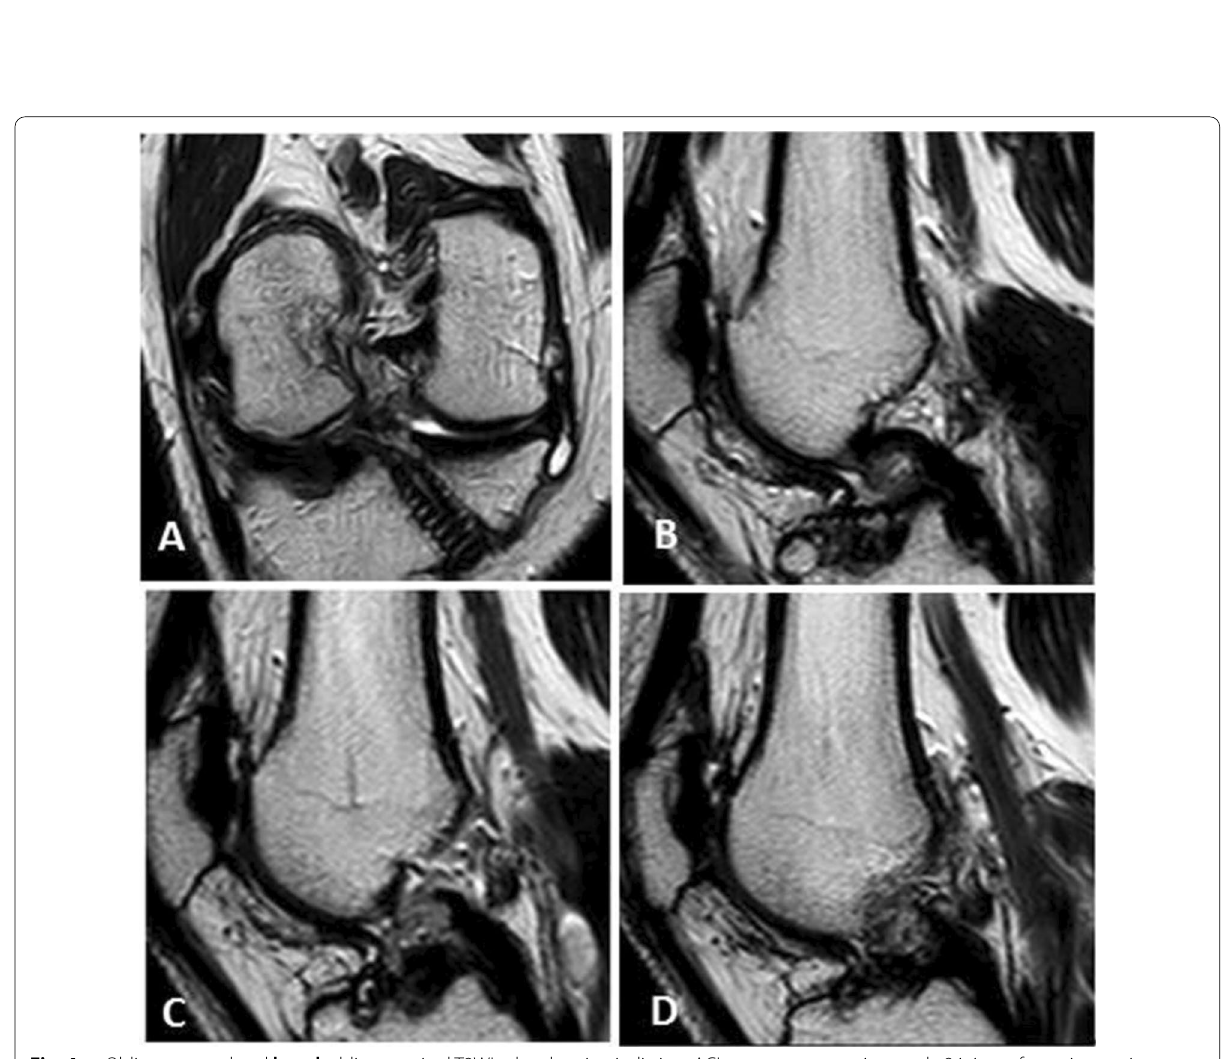
Fig. 4 a , Oblique coronal and b , c , d , oblique sagittal T2WIs also showing indistinct ACL contour, suggesting grade 2 injury of anterior cruciate ligament